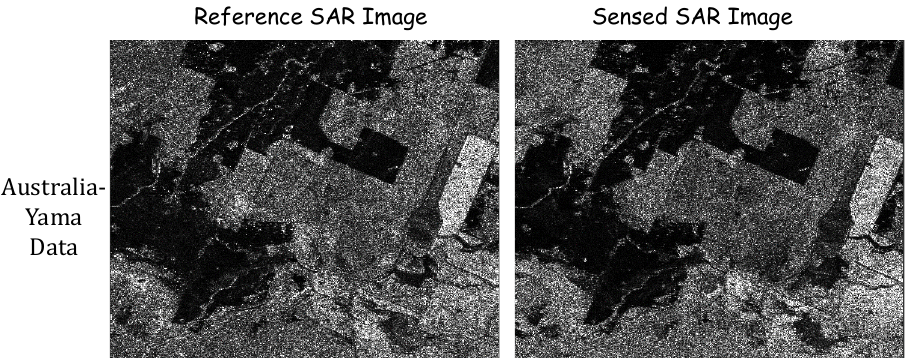
Figure 8. Reference and Sensed Images of Australia-Yama